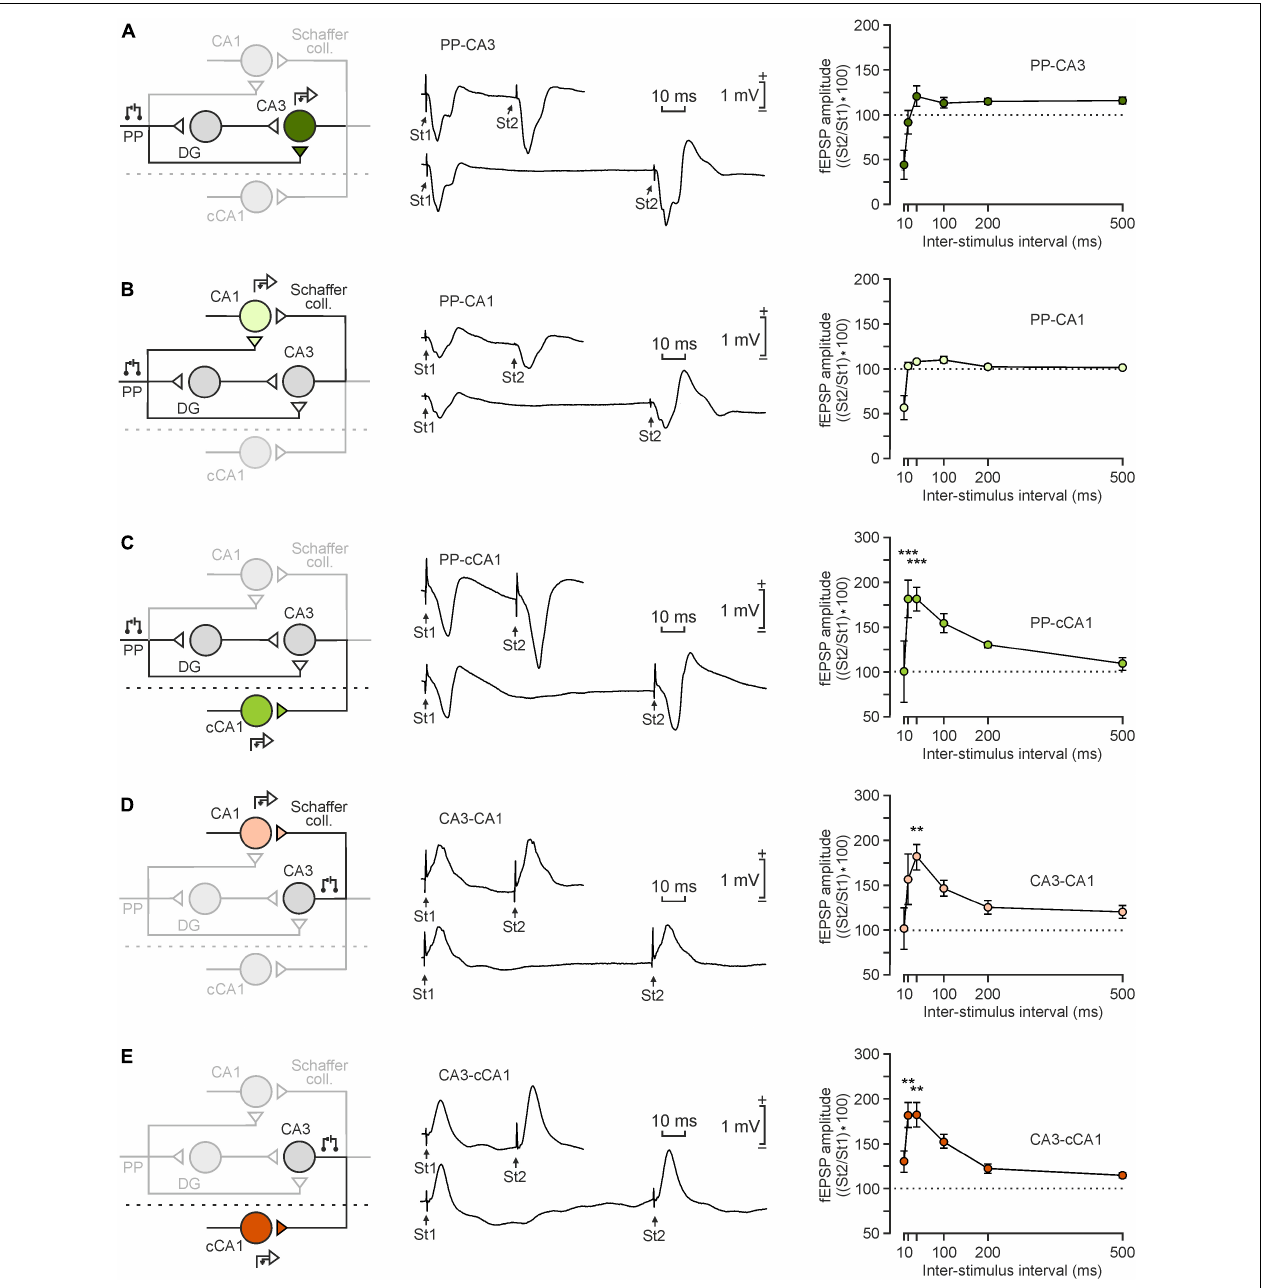
FIGURE 3 | Paired-pulse facilitation of the five selected synapses. (A–E) From left to right are illustrated a schematic representation of the synapse under study, a representative example of fEPSP evoked by the paired-pulse stimulation (St1: first stimulus; St2: second stimulus) at 40 and 100 ms interstimulus interval, and the paired-pulse facilitation induced in the five illustrated synapses: (A) , PP-CA3; (B) , PP-CA1; (C) , PP-cCA1; (D) , CA3-CA1; and (E) , CA3-cCA1. Each synapse is represented by a different color. Black circles stand for the second stimulus. Data were collected from 4 animals/synapse. Every point for each animal represents the mean value of 10 stimuli (with its corresponding SEM). The five synapses presented similar facilitation patterns in the same interstimulus intervals [ F ( 5 , 15 ) = 11.458; P < 0.001]. ** P < 0.01, *** P < 0.001 in comparison with the values collected at 500 ms —i.e., the most similar to baseline values.